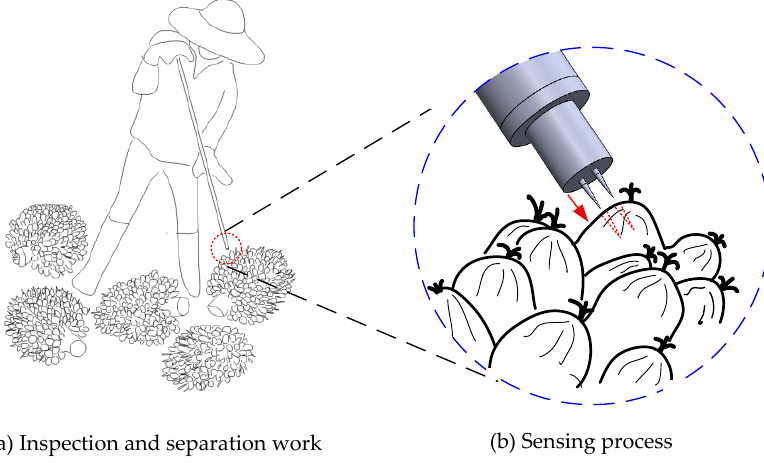
Figure 1. FFB (fresh fruit bunches) inspection using a fruit battery sensor.